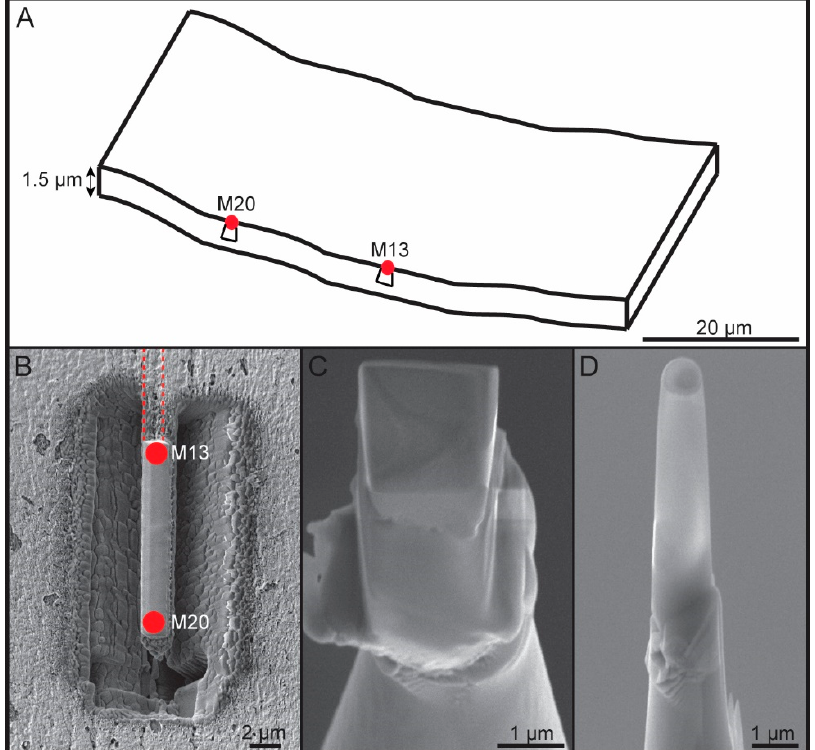
Figure 3. Details of FIB work for APT sample preparation. ( A ) Schematic of the planar configuration of a substrial line indicating the individual locations of two tip-shaped specimens. Note1 : The polished section is the top surface in the rectangle. ( B ) Image of wedge 7 on the substrial lines (dashed red lines), indicating the location of M13 and M20 tips in relation to the wedge and schematic in ( A ). ( C ) Example of a wedge fragment ready for sharpening. ( D ) Example of a tip specimen before low-Kv cleaning, ready for the local electrode atom probe (LEAP) analysis.